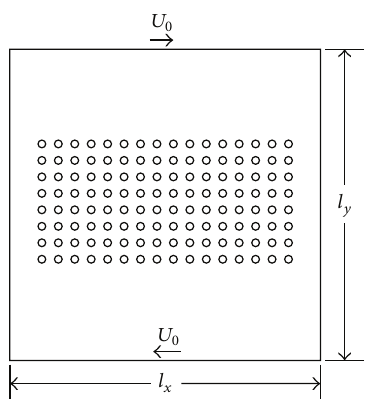
Figure 1: Schematic diagram of